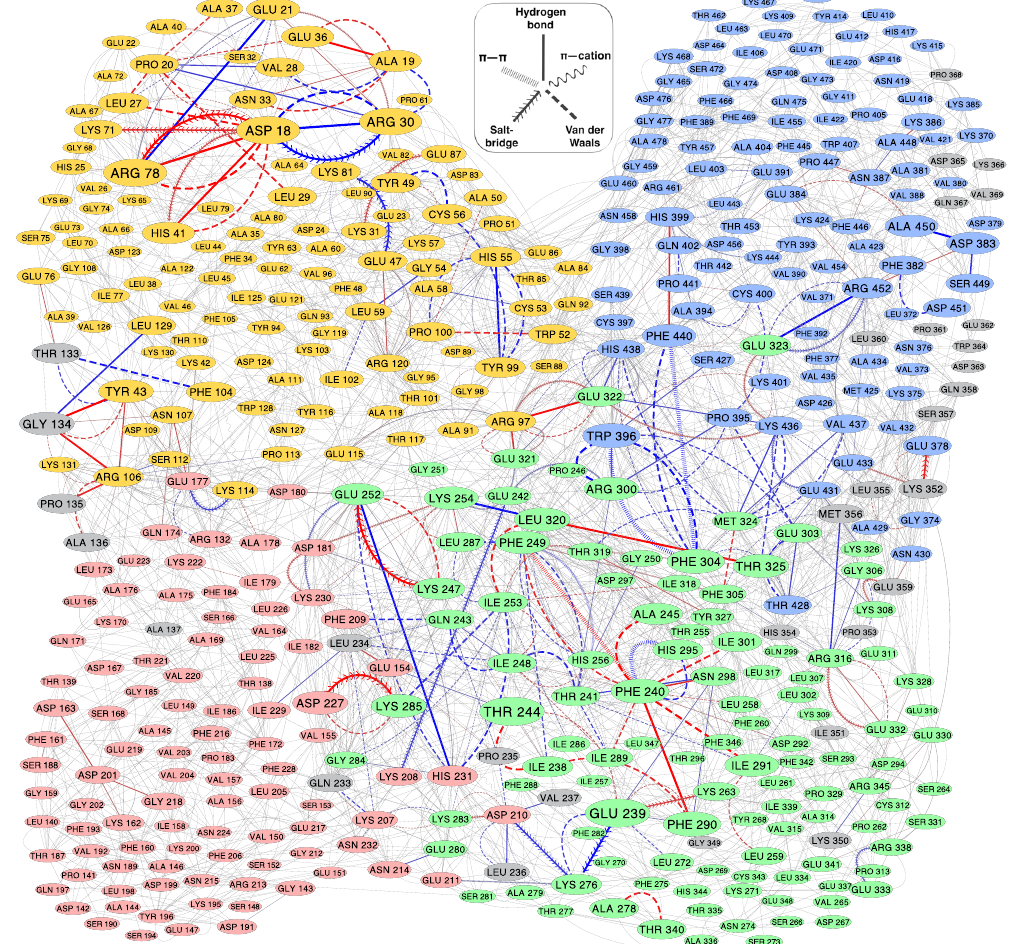
Figure 7. Dynamic residue interaction network (DRIN) in oxidized and reduced states of hPDI. The size of each vertex was assigned according to the maximum absolute weights of the edges arriving it. Sigmoid- like transformations from weights to the color or thickness of edges were used to show the interactions with unchanged weights between ox and red states as very thin grey edges, and the interactions with significantly higher persistence in one state as thick blue (red) or red (ox) edges. Nodes are colored by domains as yellow, red, green, blue and gray denote as domains a, b, b’, a’ and inter domain linkers,